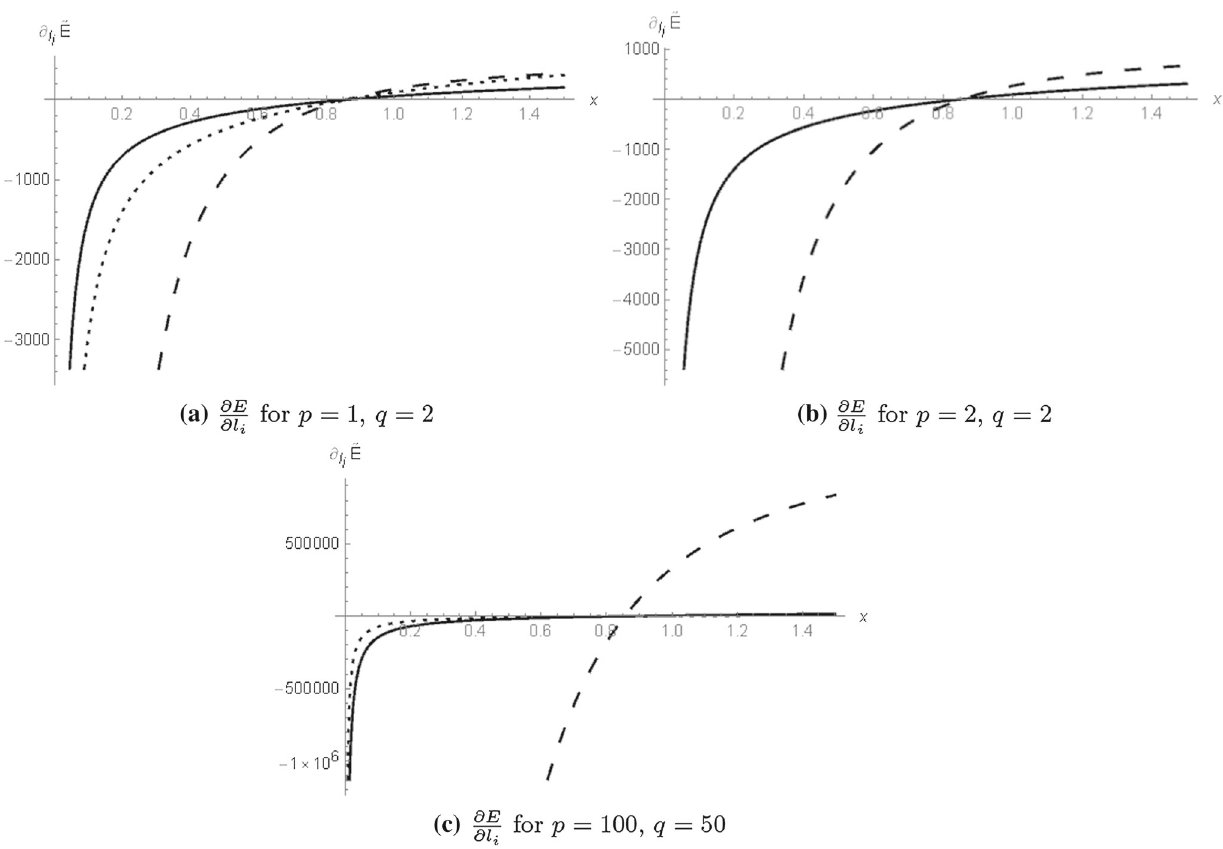
, the dotted to ∂ E ∂ l 1 l 2